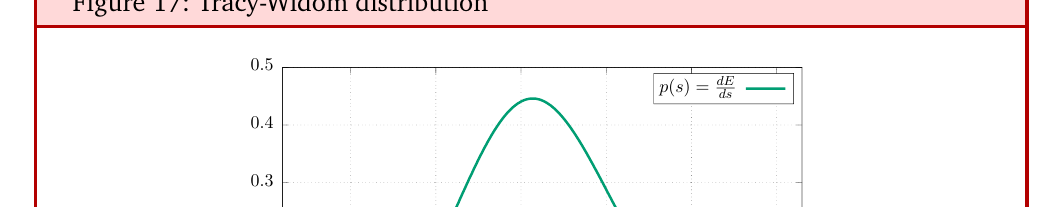
Figure 17: Tracy-Widom